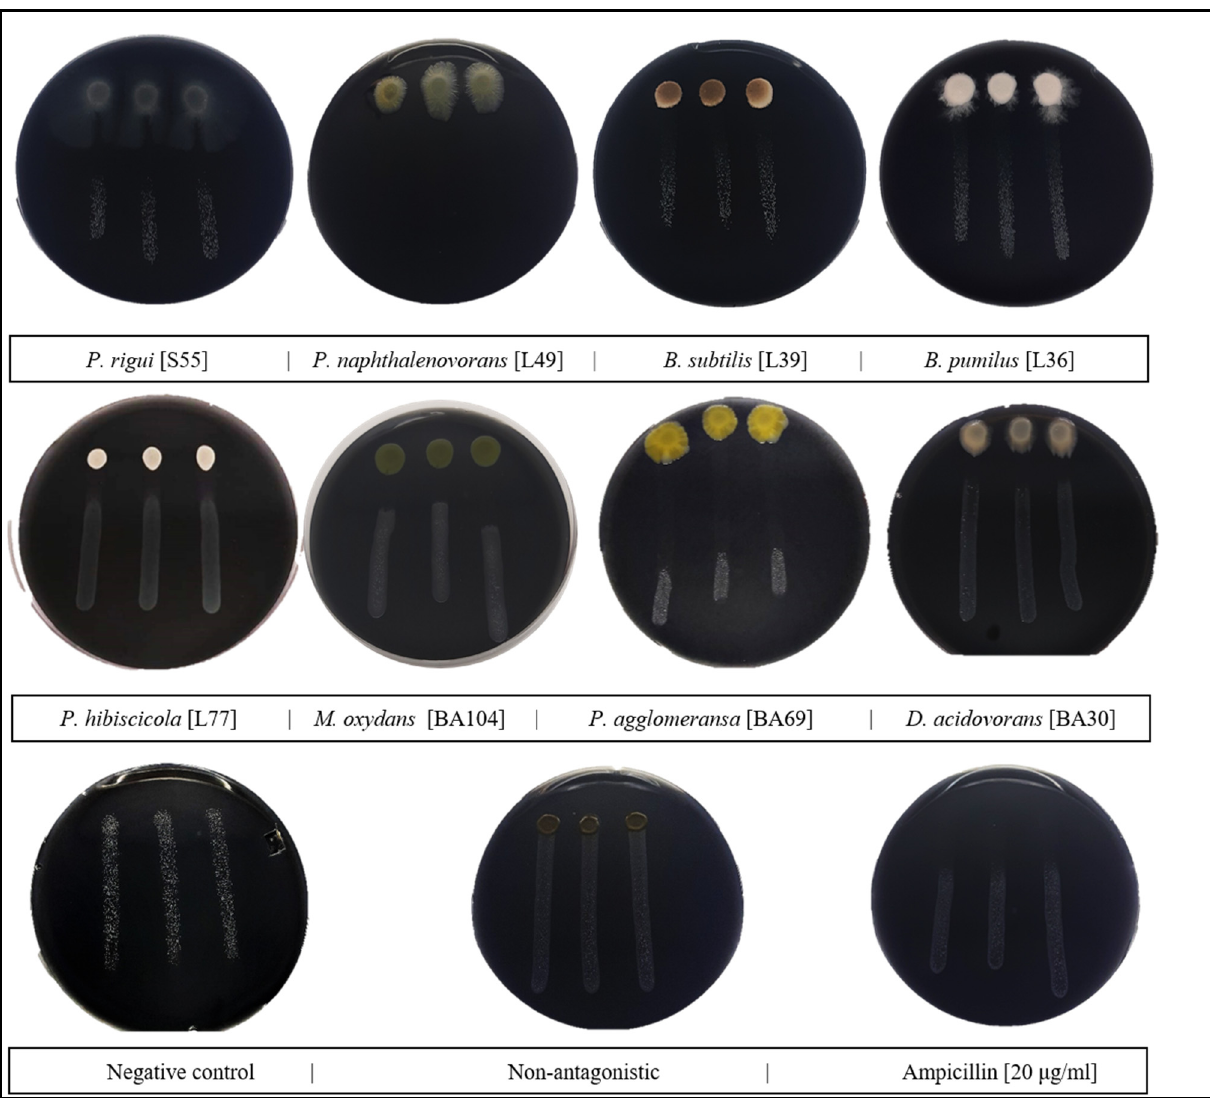
Figure 1. Dual-culture assay of antagonistic activities of epiphytic and endophytic bacteria isolated from different host plant species against X. fastidiosa